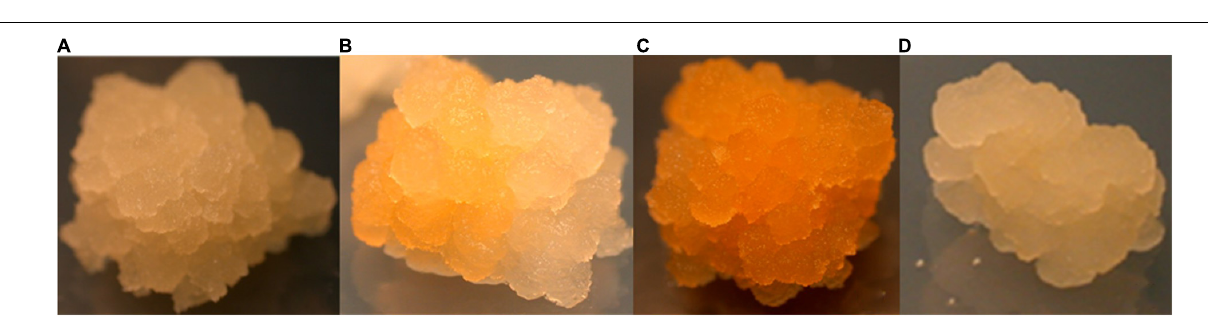
FIGURE 4 | Transgene copy number assessment in cassava using Dot Blot technique (representative image); (A) DNA samples from transgenic cassava plants generated from the current study (28 samples from construct p606 (pCAMBIA2300 + 3LB; rows 1–7) row: 8, (B) zero copy; (C) single copy; (D) double copy; (E) triple copy; each sample loaded in triplicate for comparison; (F) copy number estimates for 28 events represented in the dot blot image.